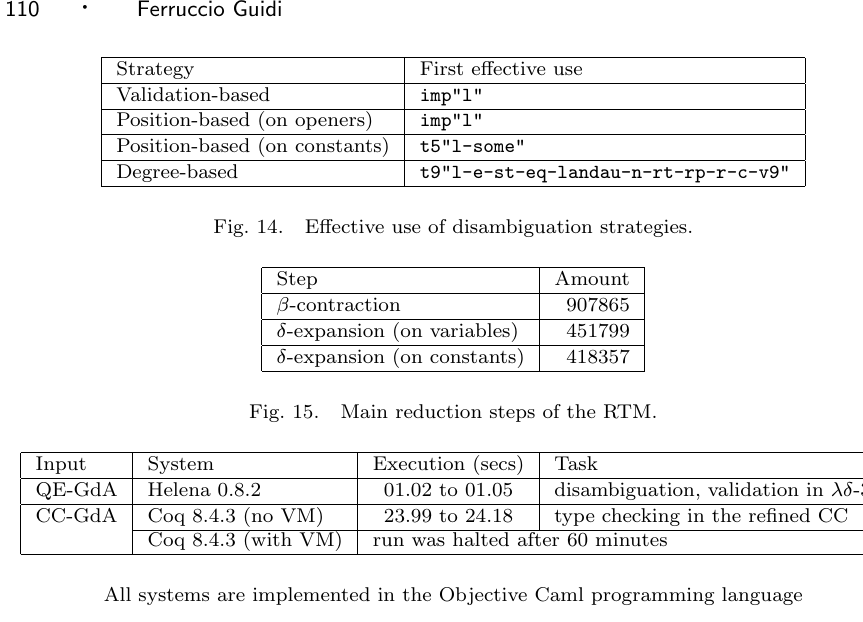
Fig. 16. Time of one run (min. and max. on 31